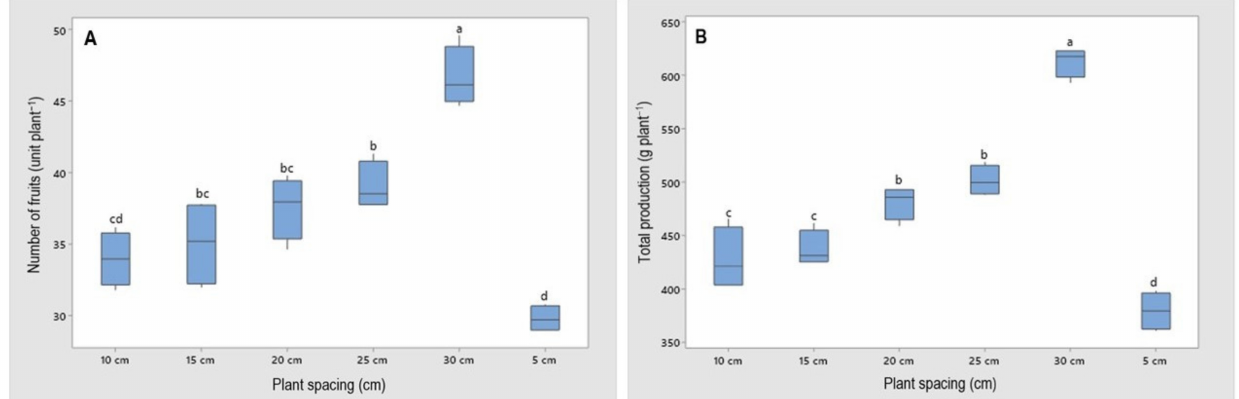
Figure 2. The response of the number of fruits per plant ( A ) and the total production ( B ) of strawberry plants cv. ‘Pircinque’, in the different spacing between plants with average of the 2018/2019 and 2019/2020 harvests. For each spacing, the different letters indicate significant differences ( p ≤